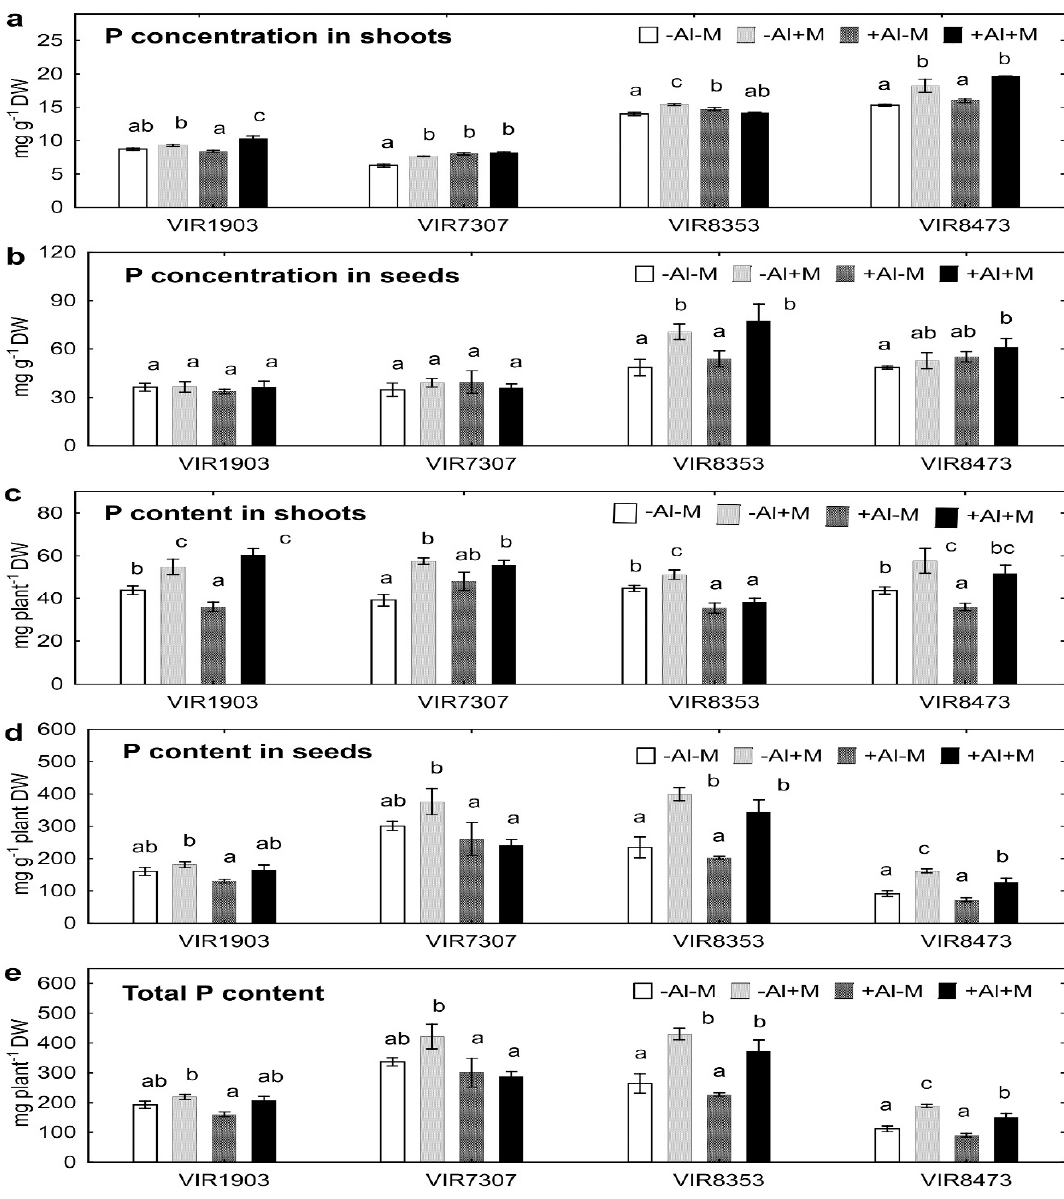
Figure 5. Phosphorus concentration in shoots ( a ) and seeds ( b ), P content in shoots ( c ) and seeds ( d ) and total P content ( e ) of pea genotypes VIR1903, VIR7307, VIR8353 and VIR8473 inoculated with microbial consortium. See details in the legend to Figure 1.